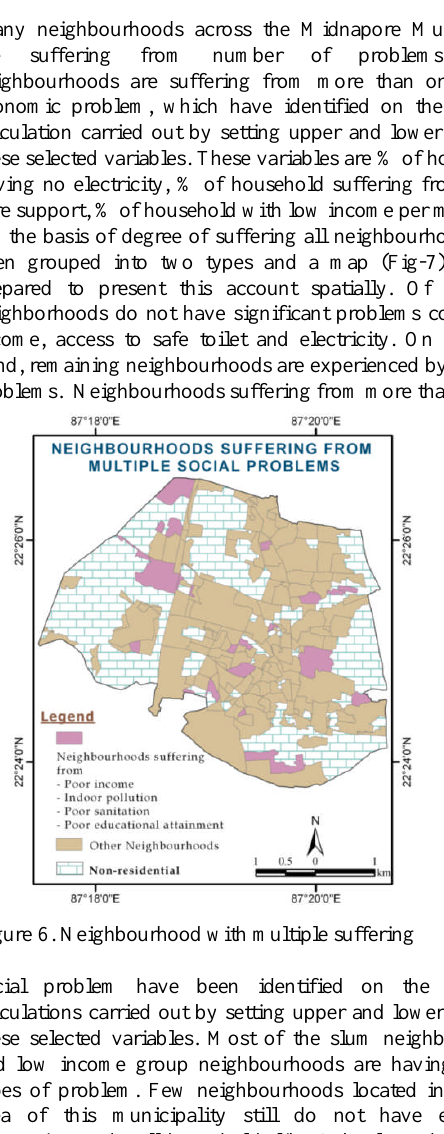
Fig-8: NHs with Degree of Deprivation